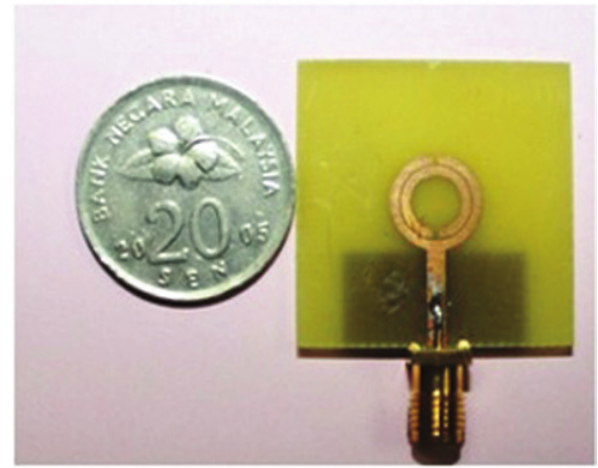
Figure 8: Reflection coefficient for different values of microstrip feed line width.